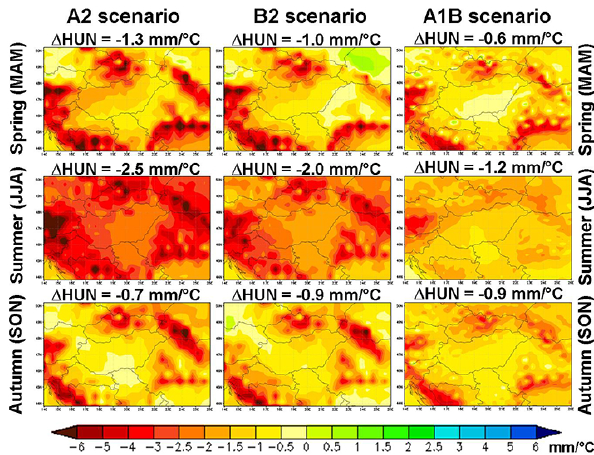
Fig. 1. Projected seasonal change of TAI for three future scenar- ios, 2071–2100, reference period: 1961–1990. The spatial average changes are shown above the maps taking into account all 229 grid points located within